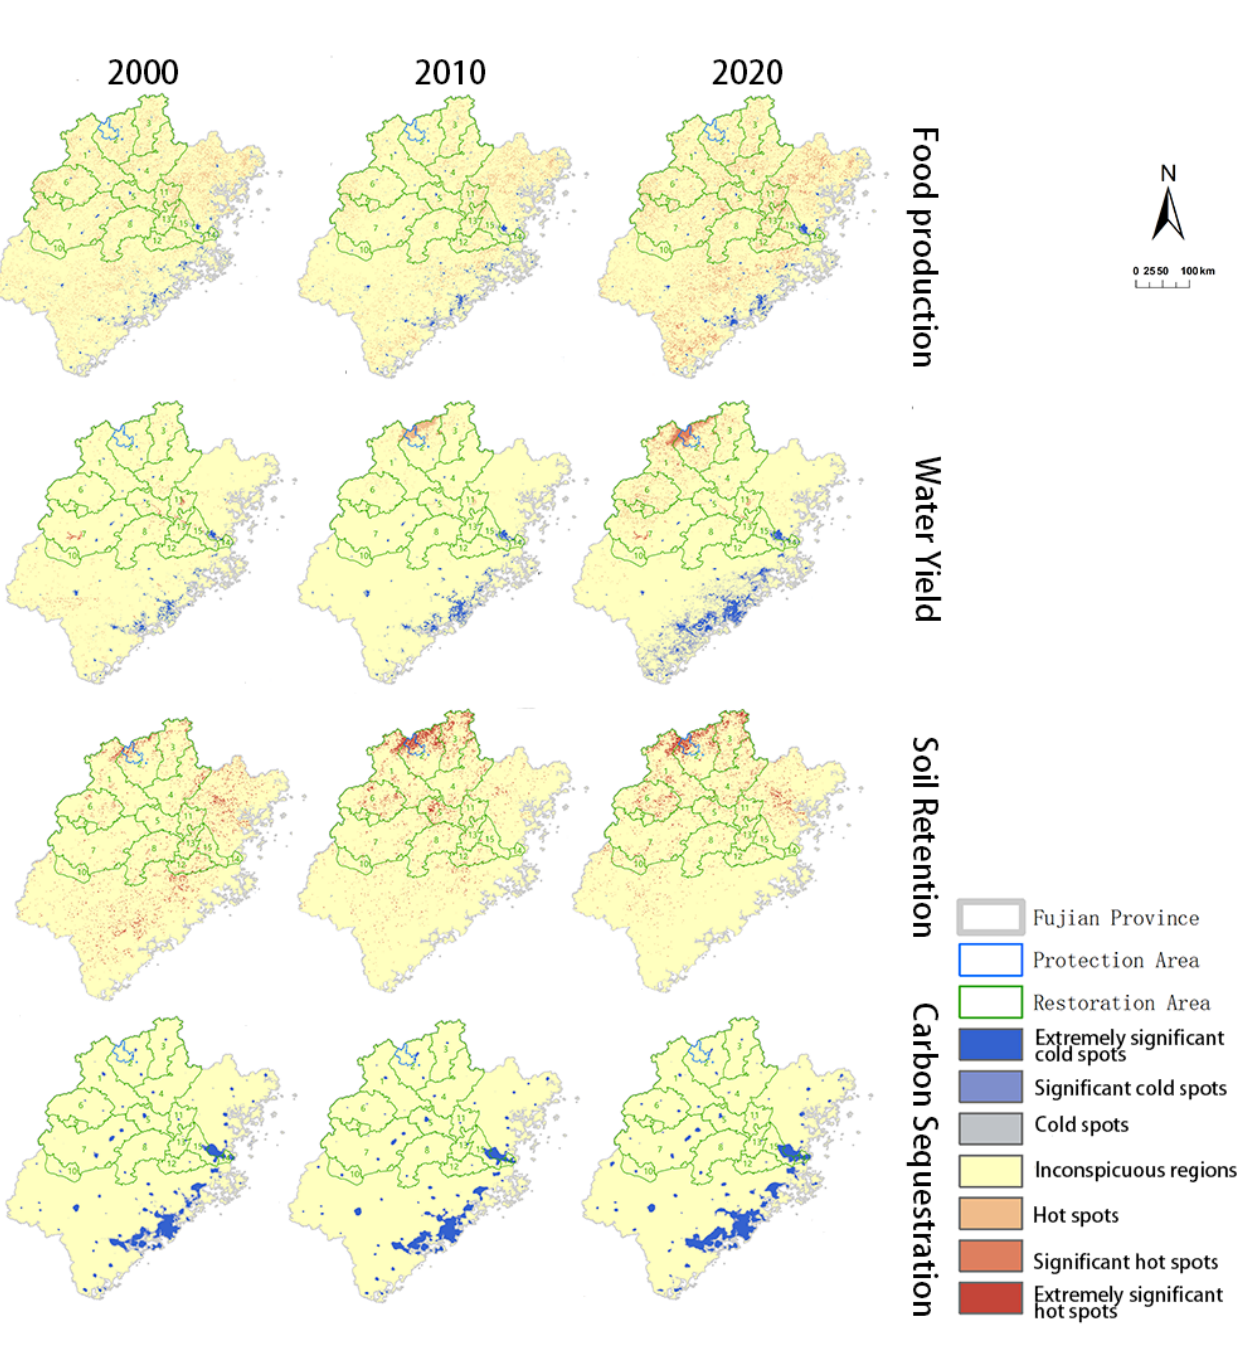
Figure 6. The variation in hot and cold spots of the ecosystem services supply − demand ratio.